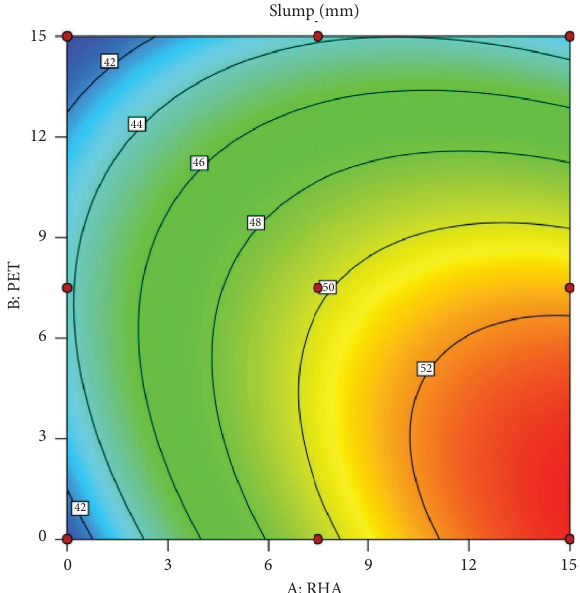
Figure 11: Response surface plot for slump.